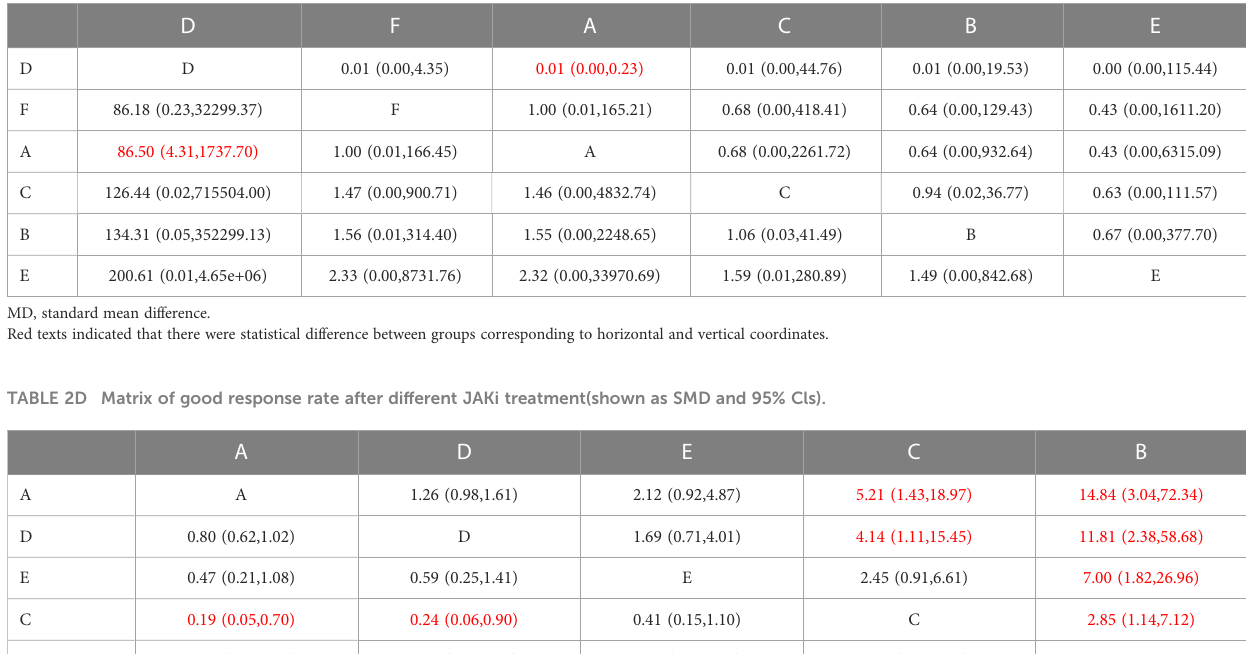
MD, standard mean difference. Red texts indicated that there were statistical difference between groups corresponding to horizontal and vertical